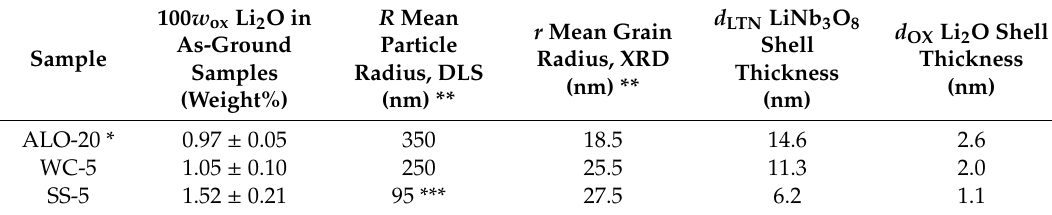
Table 3. Measured and estimated parameters of the nanocrystalline LiNbO 3 samples ground in di ff erent vials. The weight of the Li 2 O segregate was measured by titration before annealing, while the LiNb 3 O 8 shell crystallized only upon